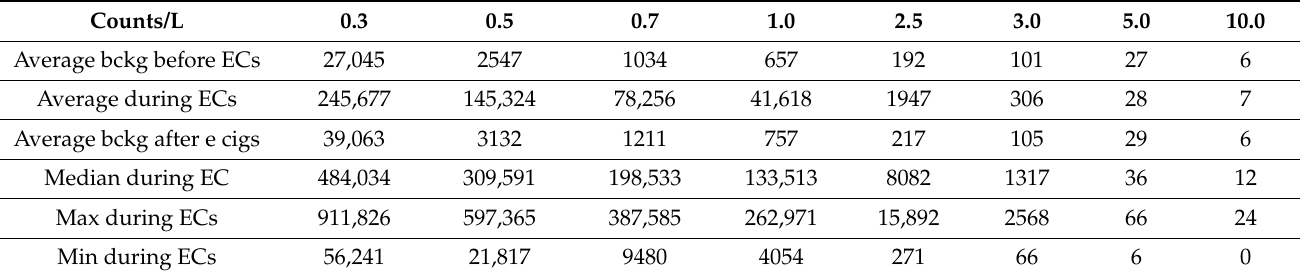
Table 3. Details of ECSHA measured in counts/L with Profiler 212-2 when using “Just Fog”